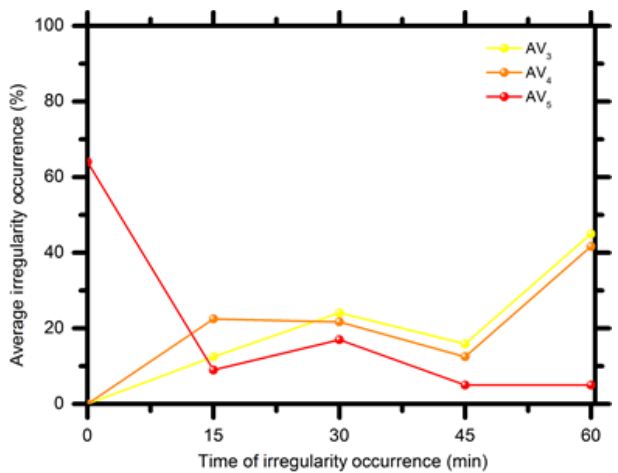
Figure 7. The average time relationship between the V zp parameter, considering the AV 3 (yellow), AV 4 (orange), and AV 5 (red) indexes, and the irregularity observations in ionograms in summer from 2009 until 2014 over São